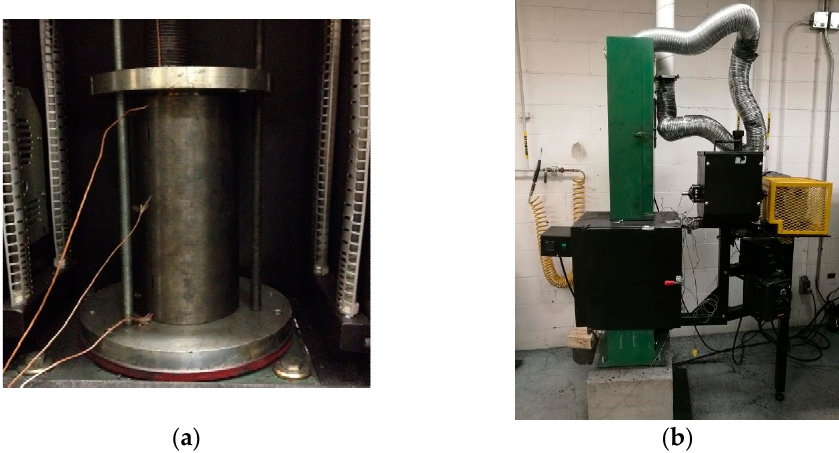
Figure 2. Device for the compaction of green anode samples by Proctor: ( a ) rotation mold; ( b ) Proc- tor.